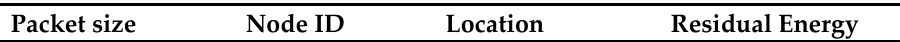
Figure 5. Format of data packet type_1.